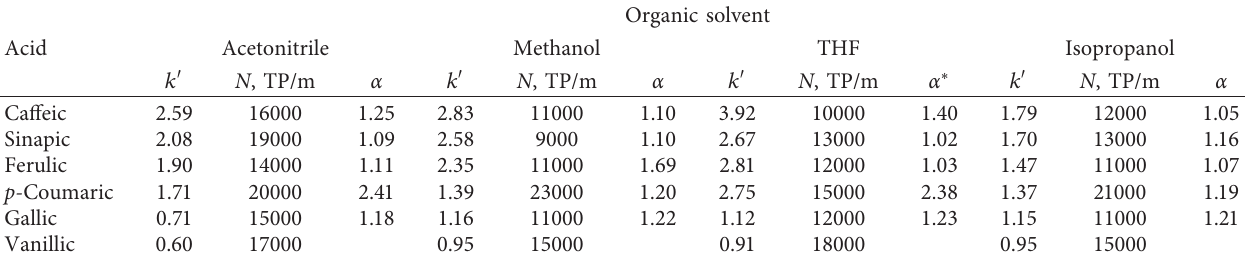
Table 2: Effect of the nature of the organic solvent in the mobile phase composition on the PA retention and the efficiency of the SP-2 column.